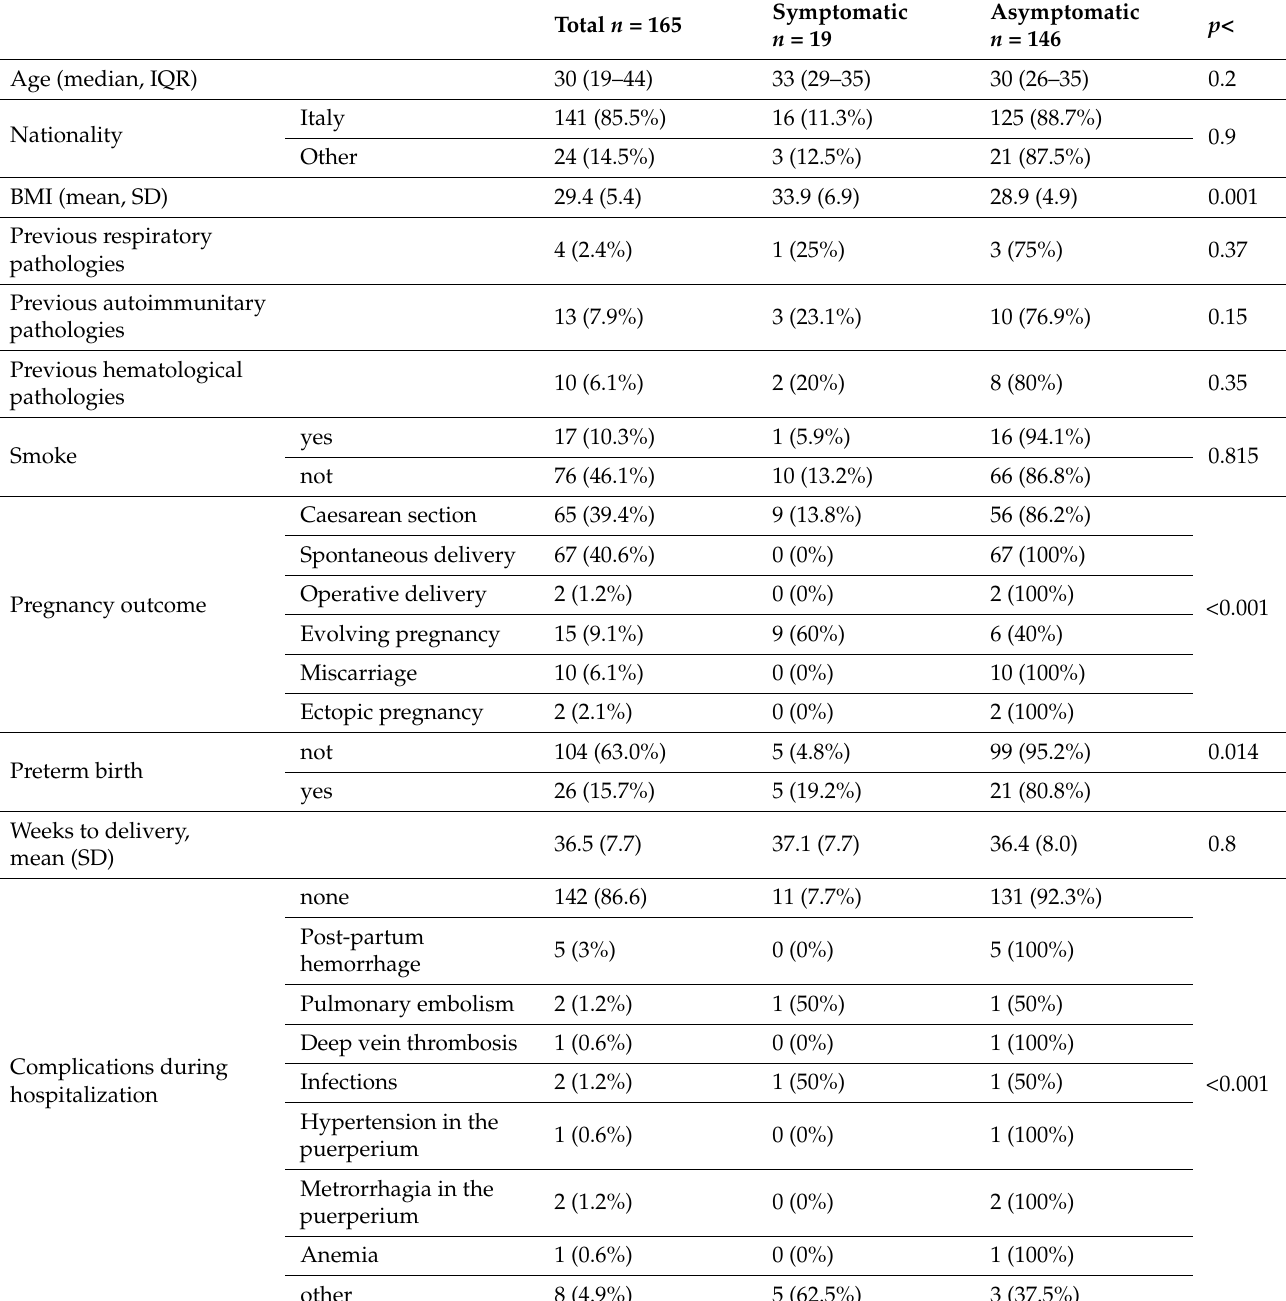
Table 2. Maternal descriptive